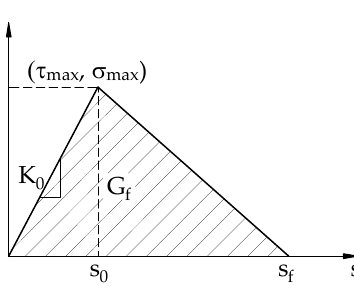
Figure 7. Bilinear traction–separation response.